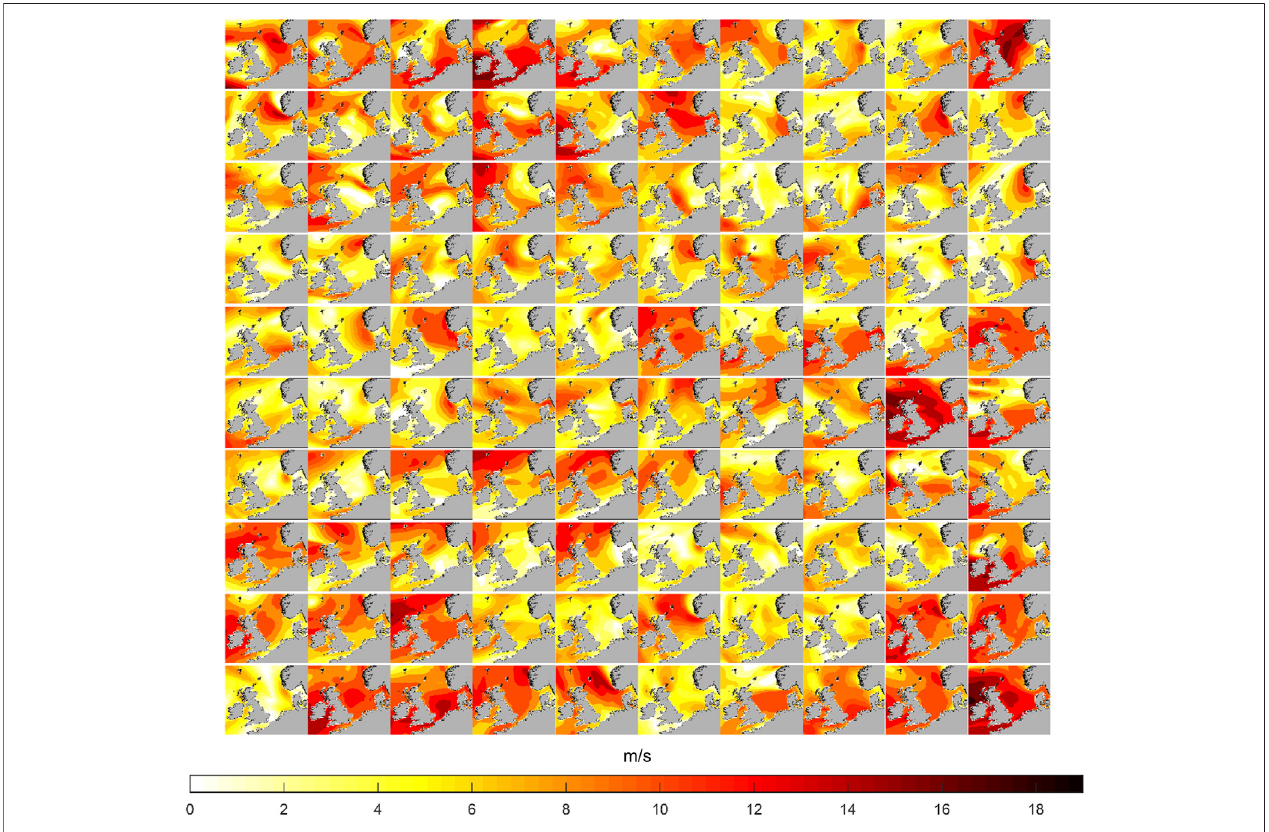
FIGURE 4 | The offshore wind speed fi elds at 10 m height for the 100 weather types, derived from ERA5.